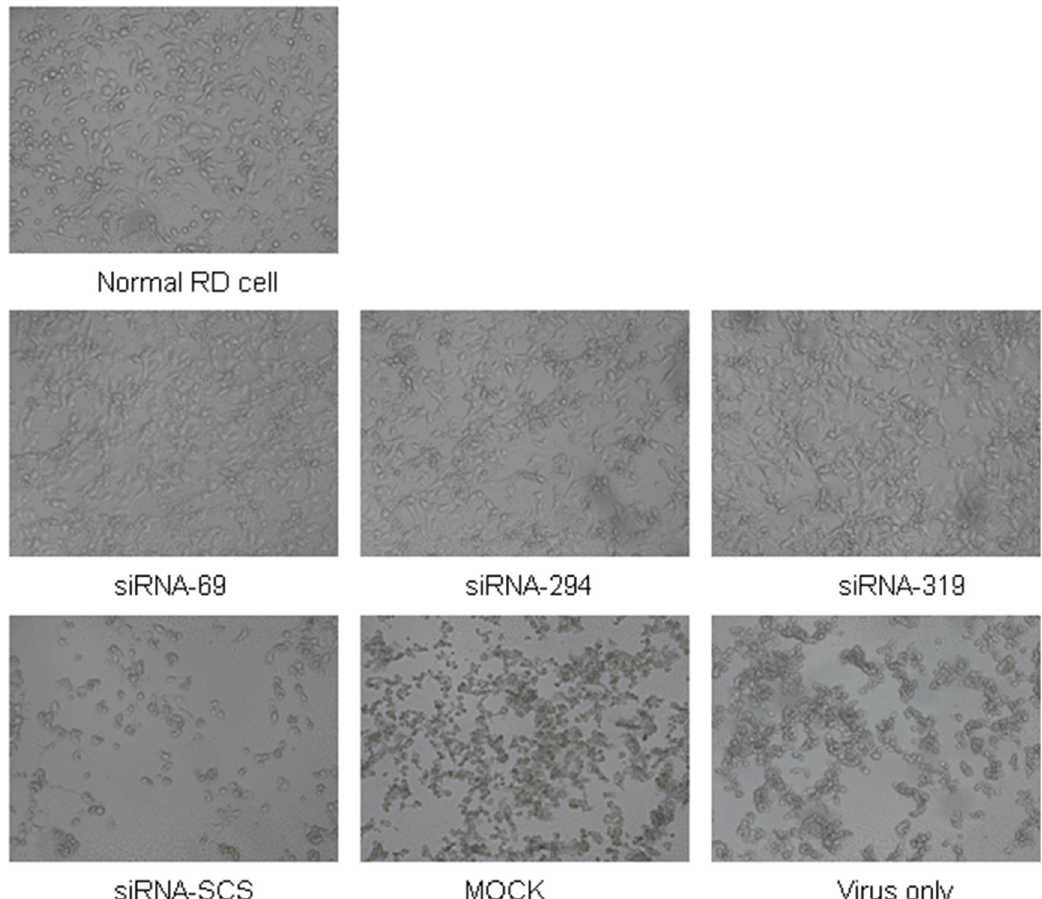
Fig 2. siRNAs protect cells against EV71-induced cytopathic effects. Morphological changes in RD cells were observed after infection. Cells were transfected with each siRNA at a final concentration of 60 nM and then infected with strain EV71-2006-52-9 at an MOI of 0.01. Micrographs were taken at 48 h postinfection under an inverted microscope. The tests were performed in three independent